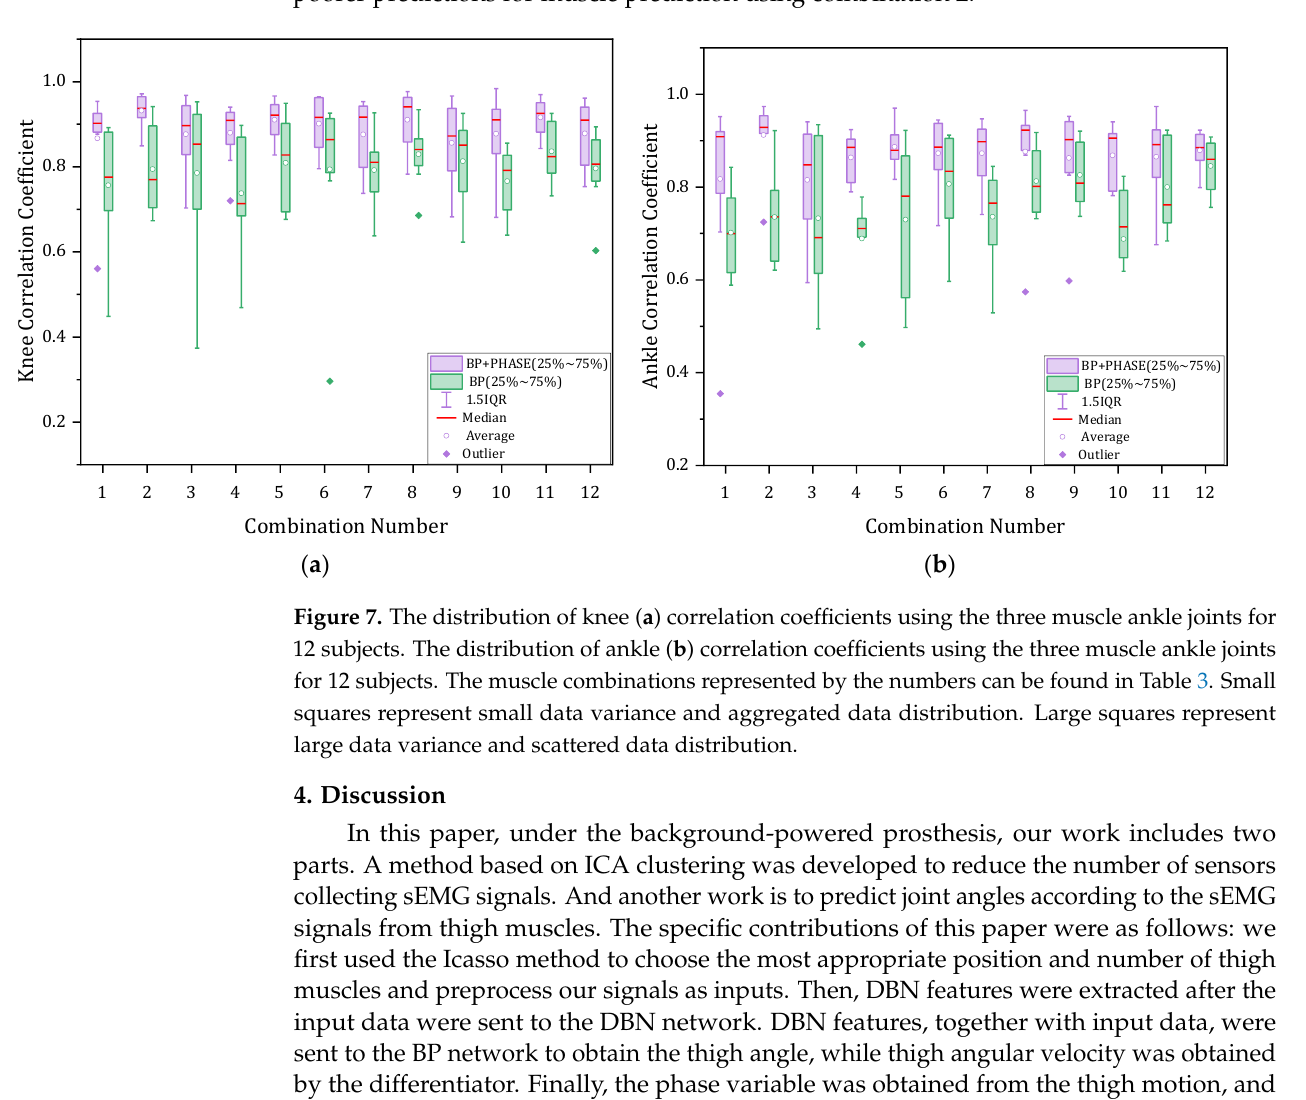
( b ) Figure 6. The comparison diagram of the combination VL + BF + GC, the combination VL + BF + GC + GM and the target values for knee ( a ) and ankle ( b ) of the subject AB14.